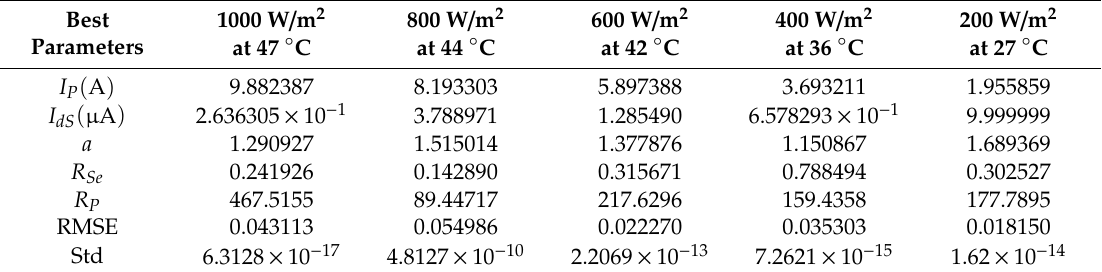
Table 13. Obtained parameters for the single-diode JKM330P-72, 310 W polycrystalline PV module.